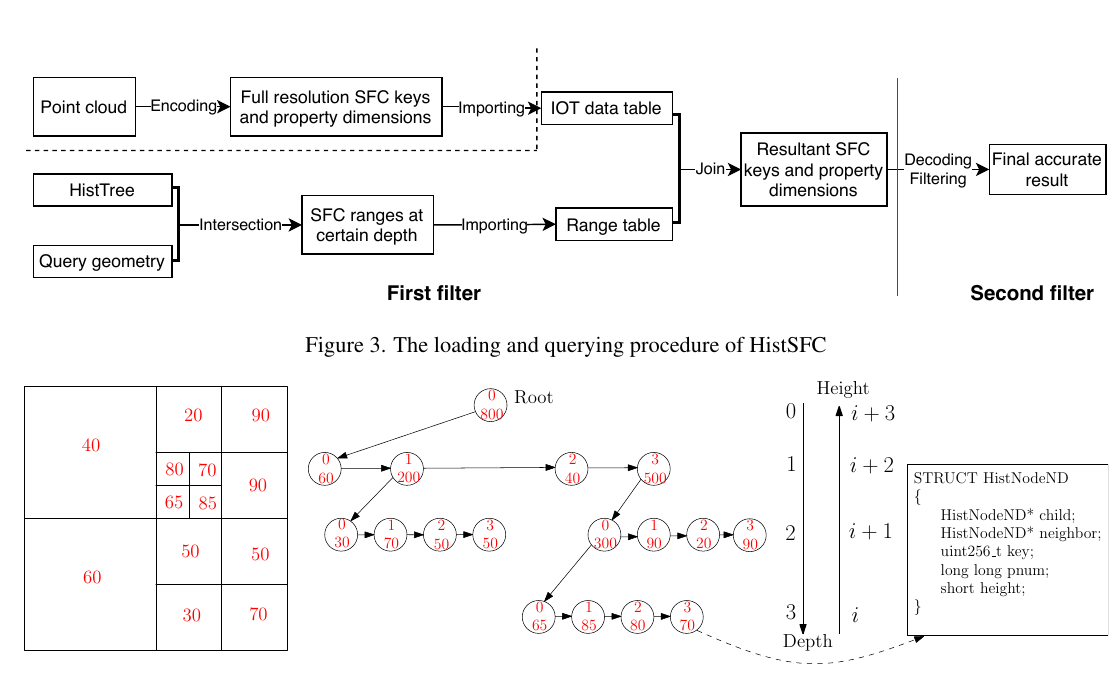
Figure 4. A 2D HistTree example, where the threshold is 100; left: point counting, middle: pointer structure of HistTree, with